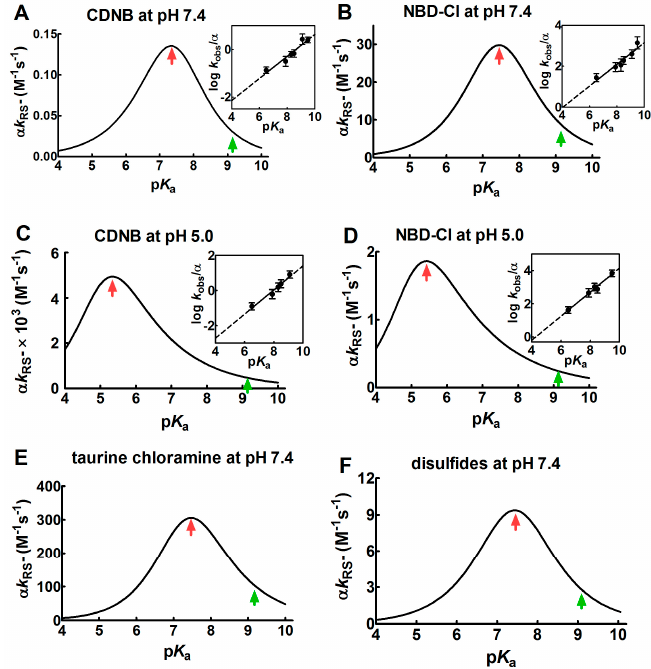
Figure 1. Dependence of kinetic constants on p K a for the reaction of thiols with different reagents. ( A – D ) Dependence of the observed second order kinetic constants ( α k RS − ) on p K a at pH = 7.4 and pH = 5.0 for the reaction of 1-chloro-2,4-dinitrobenzene (CDNB) and